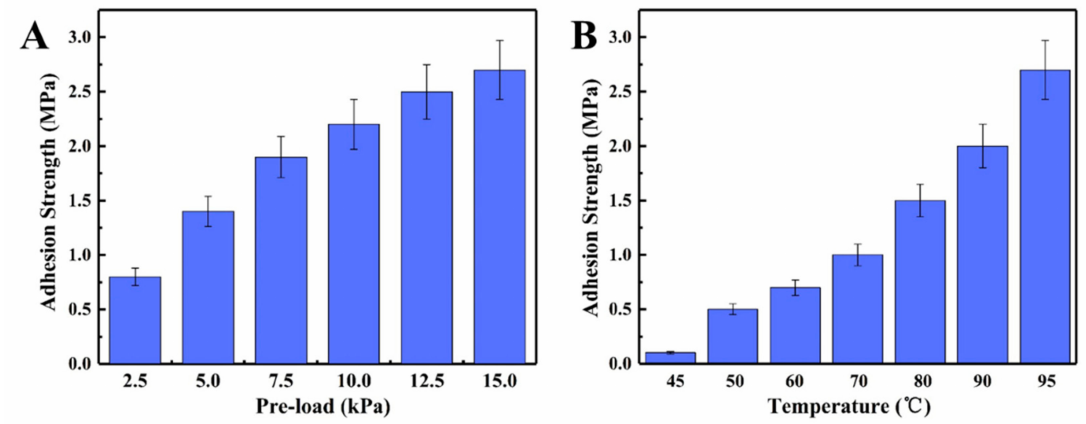
Figure 6. Adhesion strength of poly(DHHCA- co -LA)3 for ( A ) different preloading pressure at 95 ◦ C in water, ( B ) different melting temperature of preloading pressure at 15 kPa.